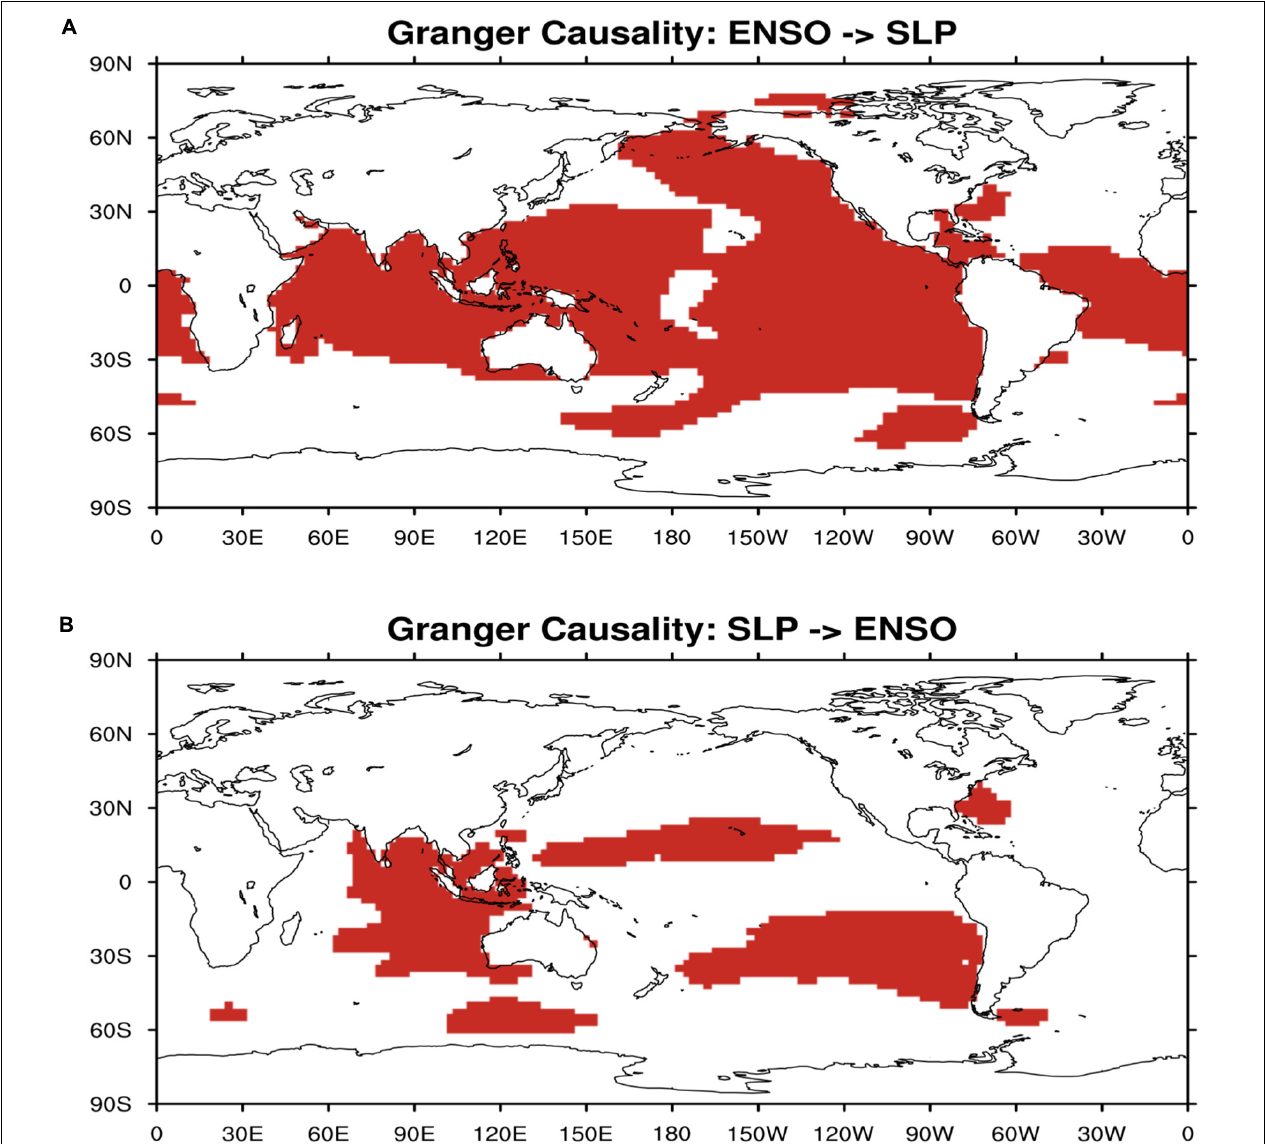
FIGURE 6 | (A) Regions where sea level pressure is Granger caused by ENSO index (red shaded). (B) Regions where sea level pressure causes ENSO (red shaded).